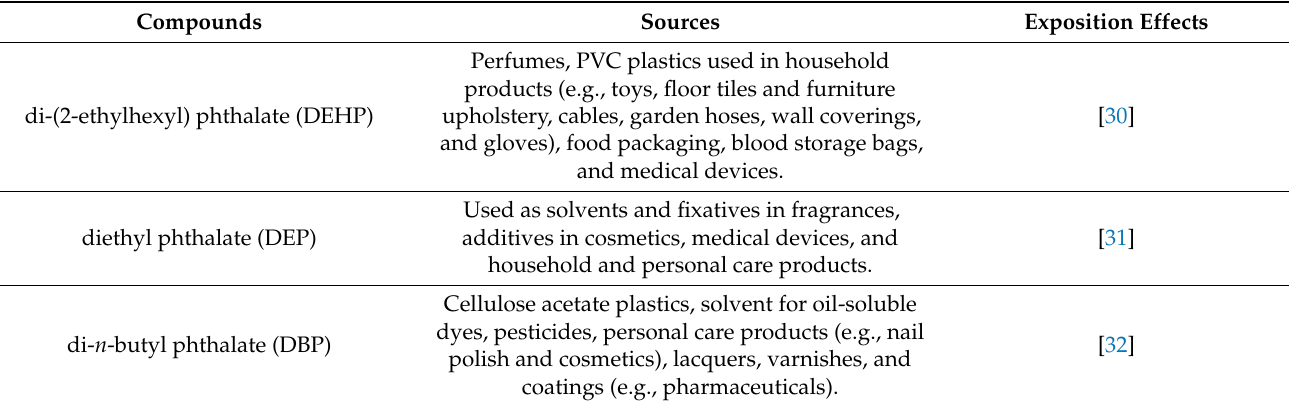
Table 1. Example of